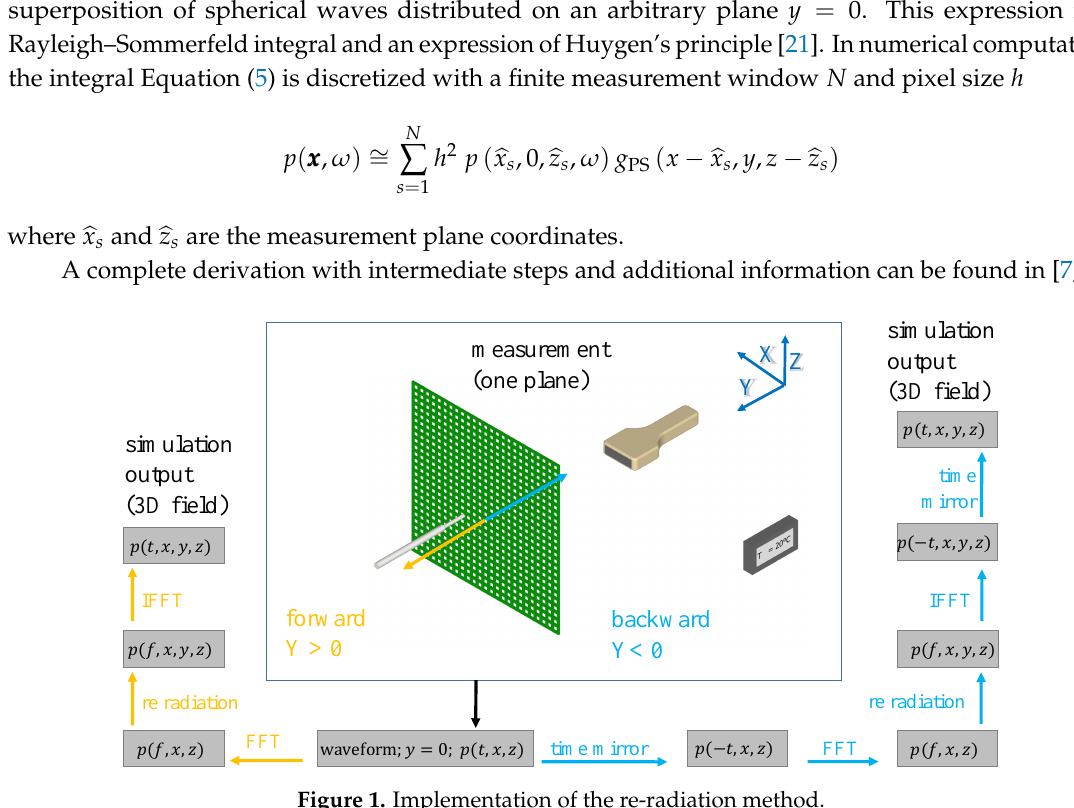
Figure 1. Implementation of the re-radiation